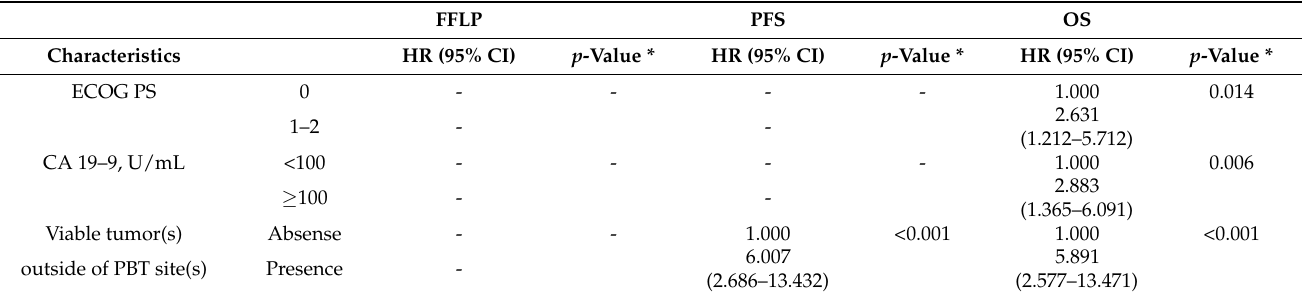
Table 3. Multivariate analysis of the pre-treatment characteristics for the free from local progression (FFLP), progression-free survival (PFS), and overall survival (OS). FFLP PFS OS